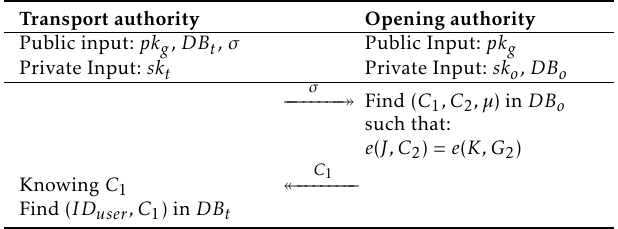
Table 3. Protocol for the de-anonymization of a user.